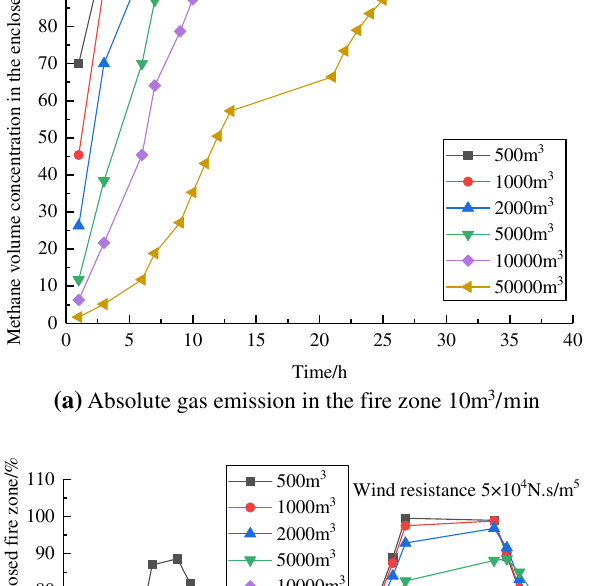
(c) Large wind resistance and large amount o fabsolute gas emission